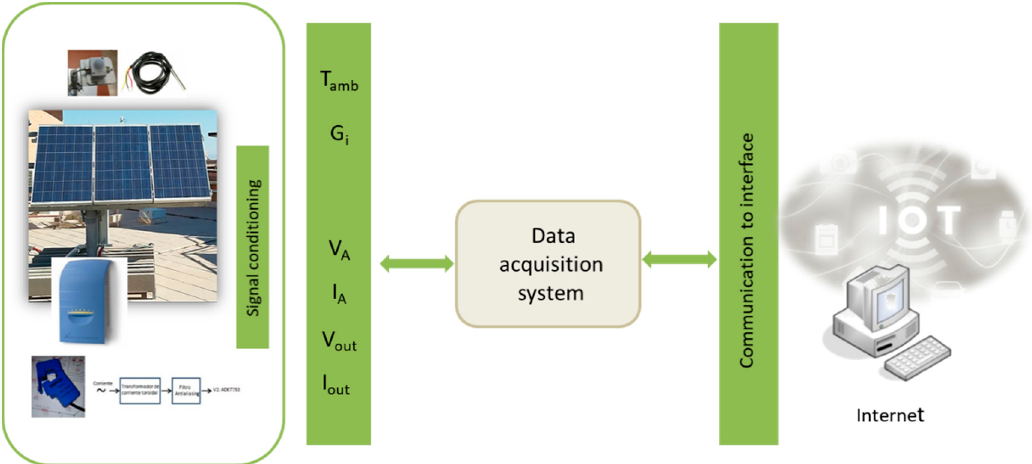
Figure 2. The block diagram of the prototype for monitoring a photovoltaic self-consumption system.